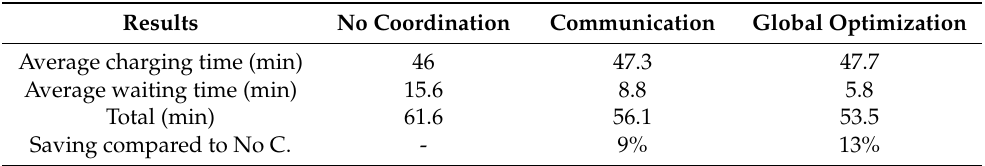
Table 3. Average charging and waiting time for the three scenarios.